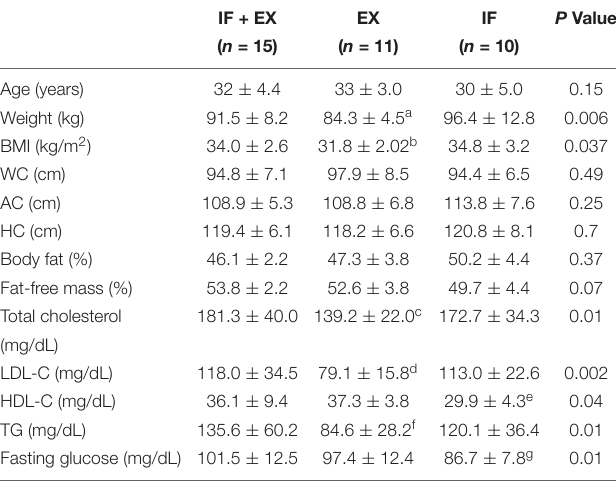
TABLE 2 | Baseline characteristics.